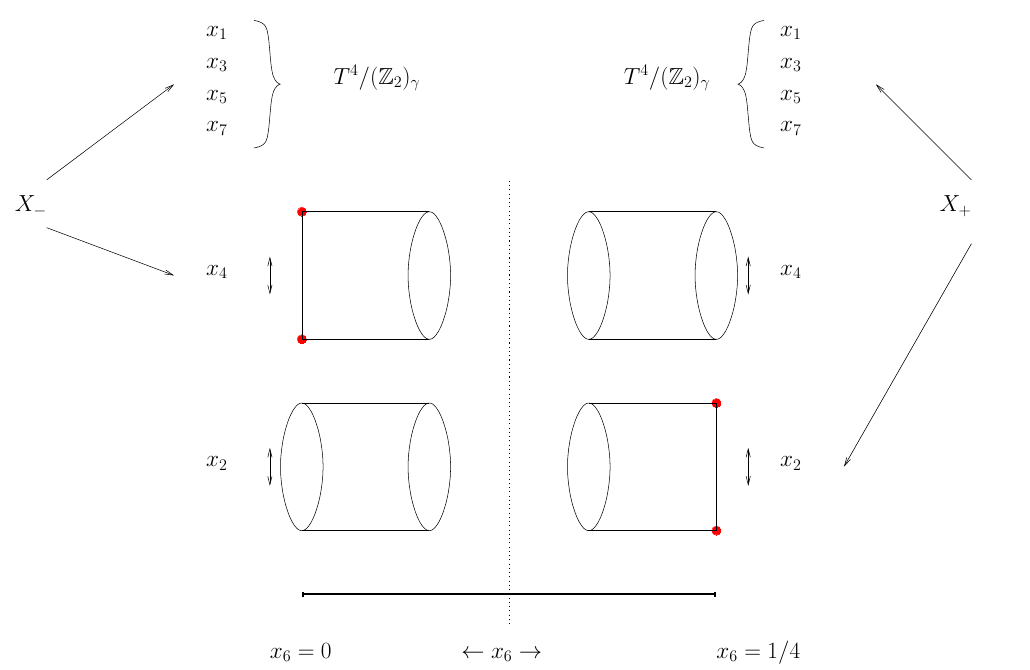
Figure 4 . Cutting along x 6 = 1 , the orbifold J is decomposed into two halves S 1 (cid:2) X (cid:0) and 8 S 1 (cid:2) X + with isomorphic Calabi-Yau orbifolds X (cid:0) and X + . These are both realized as a (constant) (cid:12)bration of a K3 orbifold T 4 = ( Z 2 ) (cid:13) over a base which (topologically) forms an open S 2 due to the degeneration of the S 1 formed by x 2 (for X (cid:0) ) and x 4 for ( X + ).